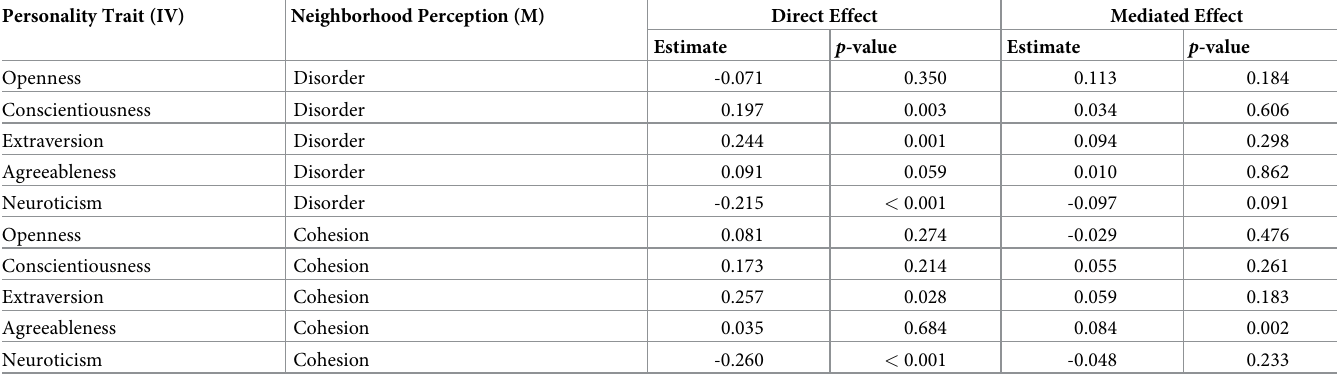
Table 4. Neighborhood perceptions (M) as mediators of the association between personality traits (IV) and neighborhood satisfaction (DV). Personality Trait